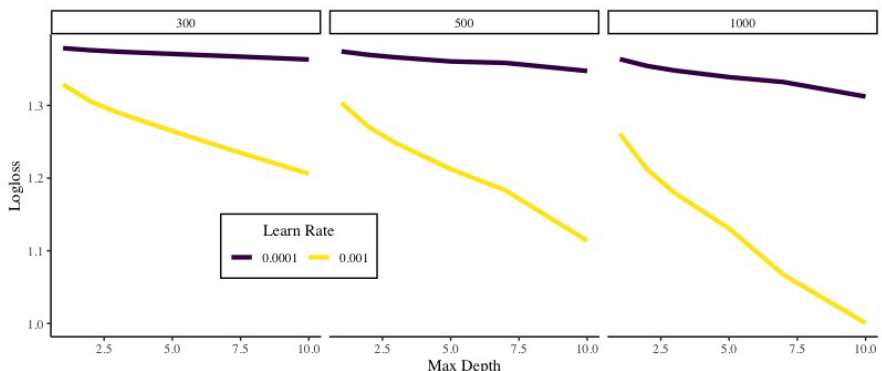
Figure 3. Visualization of the results from tuning gradient boosted forests to predict claim frequency on the BI data. Here, we show the change in logloss across different values of max depth of each tree in the gradient boosted forest. The left pane shows the results when the number of trees is 300, the middle pane shows when the number of trees is 500, and the right pane shows the results when the number of trees is 1000. Each pane contains two lines of different colors representing different learning rates.